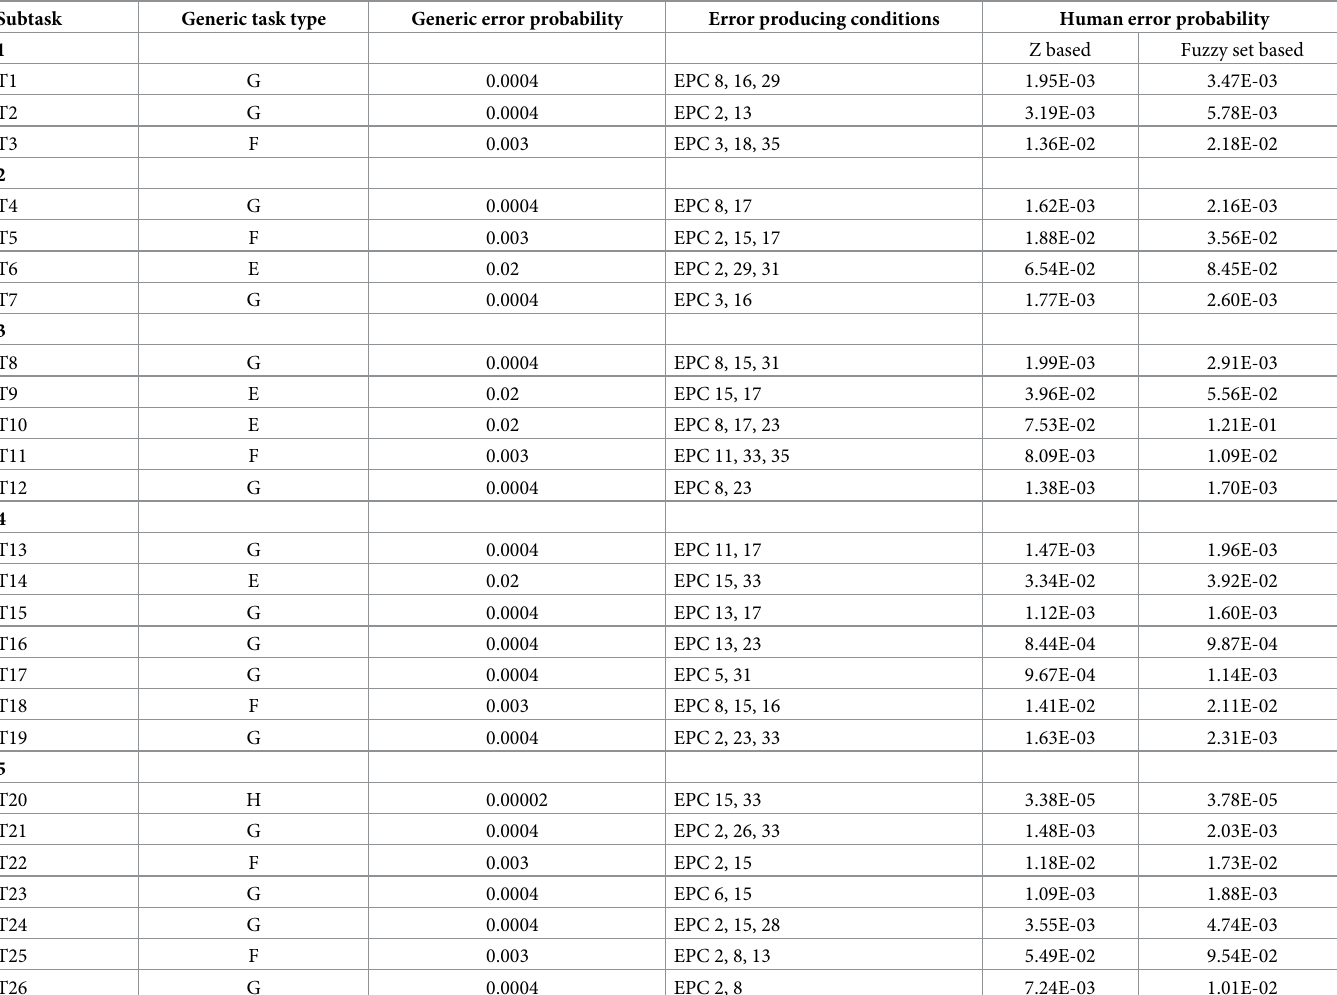
Table 6. Human error probability